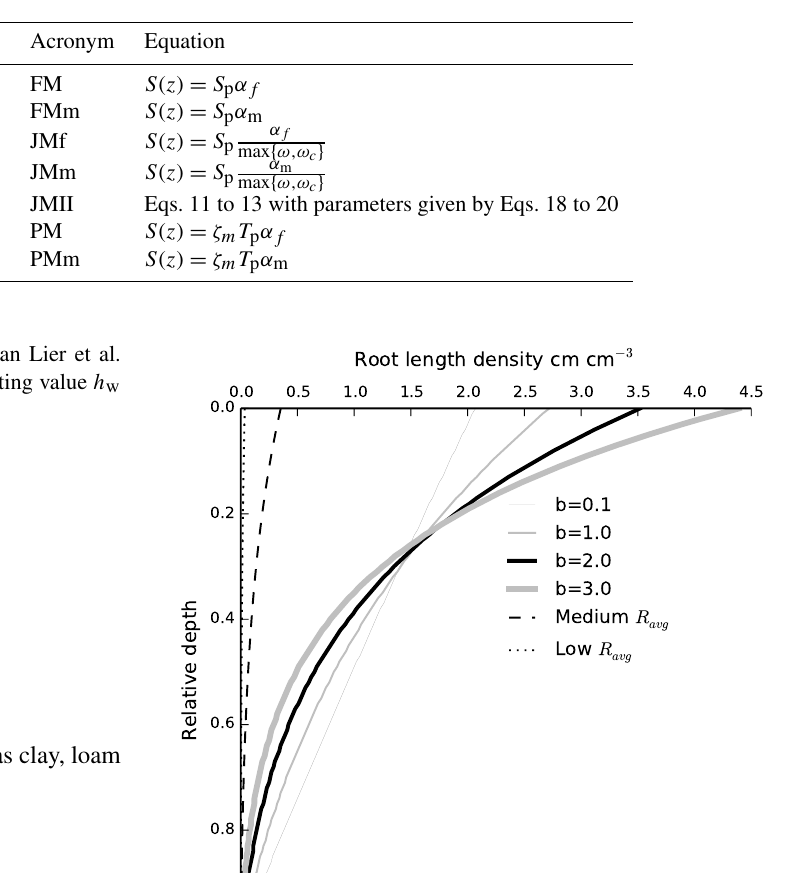
Table 1. Summary of empirical models used in this study. α f and α m are the Feddes et al. (1978) (Fig. 1a) and proposed reduction functions (Fig. 1b), S p (Eq. 4) is the potential root water uptake, ω (Eq. 11) and ω c are the weighted stress index and threshold value in the Jarvis (1989) model, and ζ m (Eq. 25) is the weighted stress index in the proposed models.